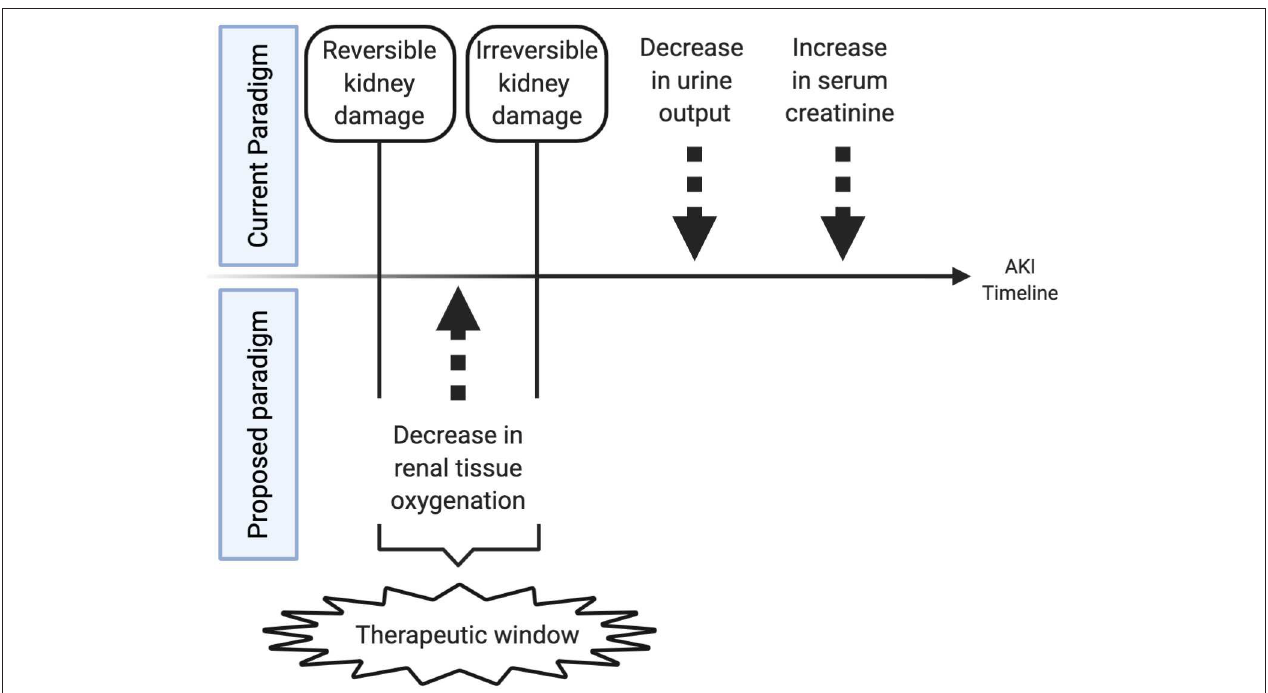
FIGURE 4 | Therapeutic window created by monitoring renal tissue oxygenation. This figure shows the theoretical timeline of changes in a patient with acute kidney injury. Initially tissue oxygenation changes occur followed by a later decrease in urine output and an increase in serum creatinine. Changes in urine output and serum creatinine may signal permanent tissue injury, while changes in tissue oxygenation may reflect an earlier time period when renal ischemia is still reversible and responsive to fluid management, transfusions, inotropic support, or medication administration that may resolve ongoing